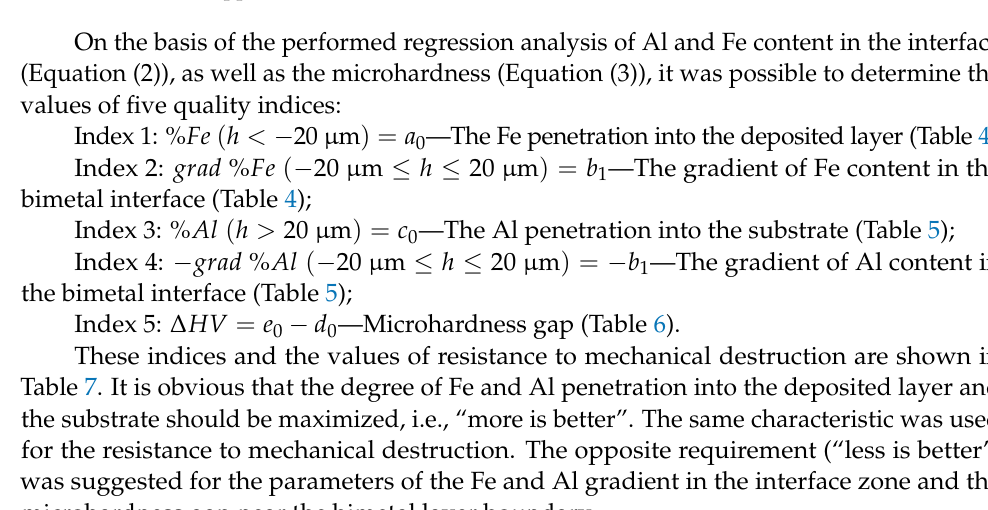
Figure 8. Piecewise approximation of microhardness distribution in the bimetal interface (SLM mode 2).